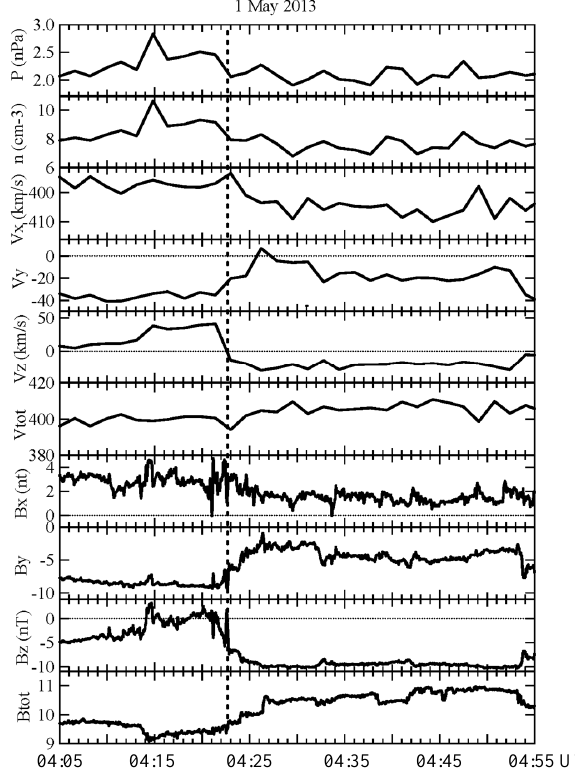
Figure 3. From top to bottom, Van Allen Probe B observations of the three components of the magnetic field and its magnitude, the three components of the electric field, V x component in GSM co- ordinates, and the ratio of perturbation in the azimuthal component of electric field ( δEy ) to perturbation in the compressional com- ponent of magnetic field ( δBz ) from 05:40 to 06:00UT. The latter parameter provides a measure of the spacecraft’s distance from the equatorial node.